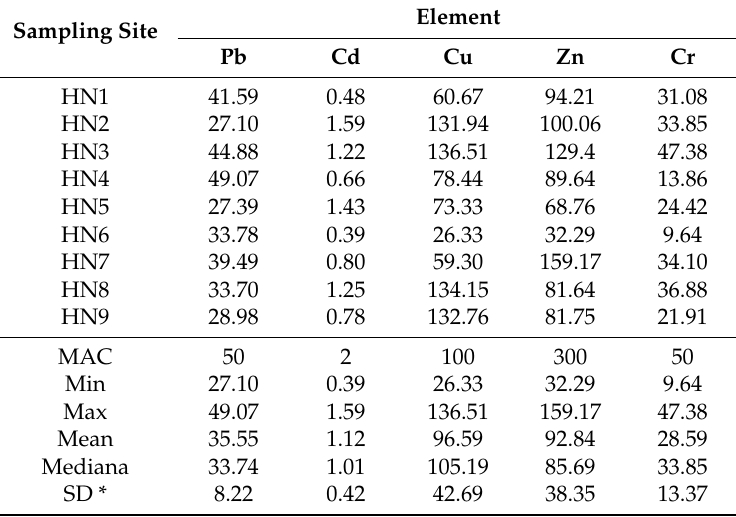
Table 4. Total contents and descriptive statistics of elements in Herceg Novi (HN) urban parks soil samples for this study (mg ¨ kg ´ 1 ).